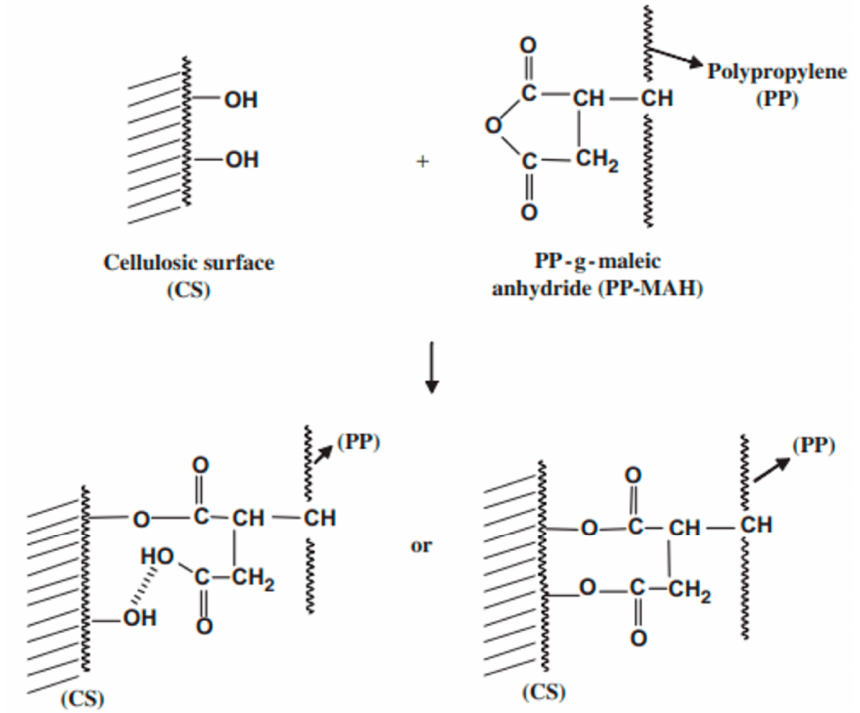
Figure 10. Illustration of coupling agent polypropylene-g-anhydride maleic acid (PP-MAH) and potential esterification process and H-bond interactions at the interface of a cellulosic fiber [169].